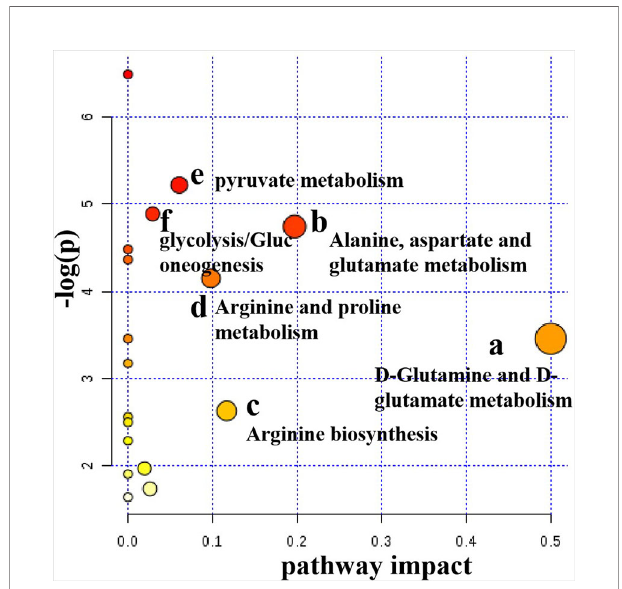
FIGURE 10 | Pathway analysis of serum metabolites affected by CSE.